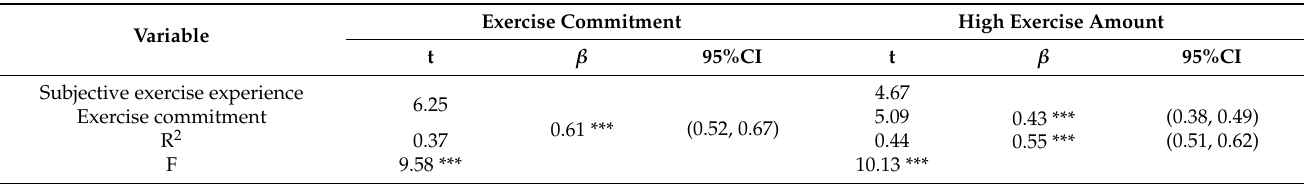
Table 8. The mediating effect of exercise commitment between subjective exercise experience and high exercise amount.